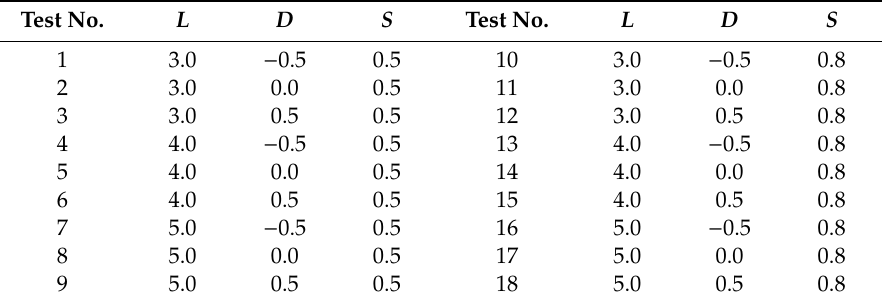
Table 4. Experimental plan of fiber laser welding